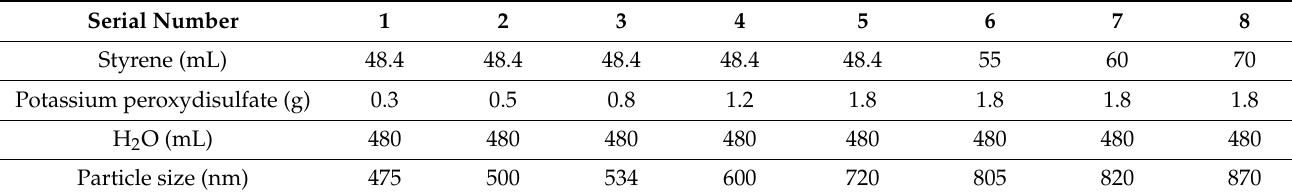
Table 2. Emulsion polymerization formula and corresponding particle size.